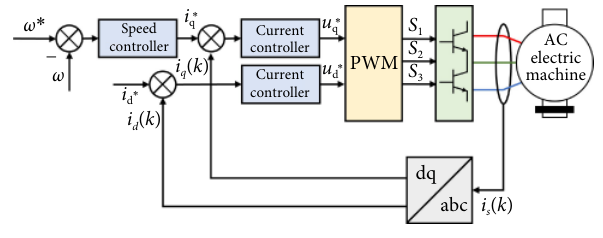
Fig. 23 Control scheme diagrams of